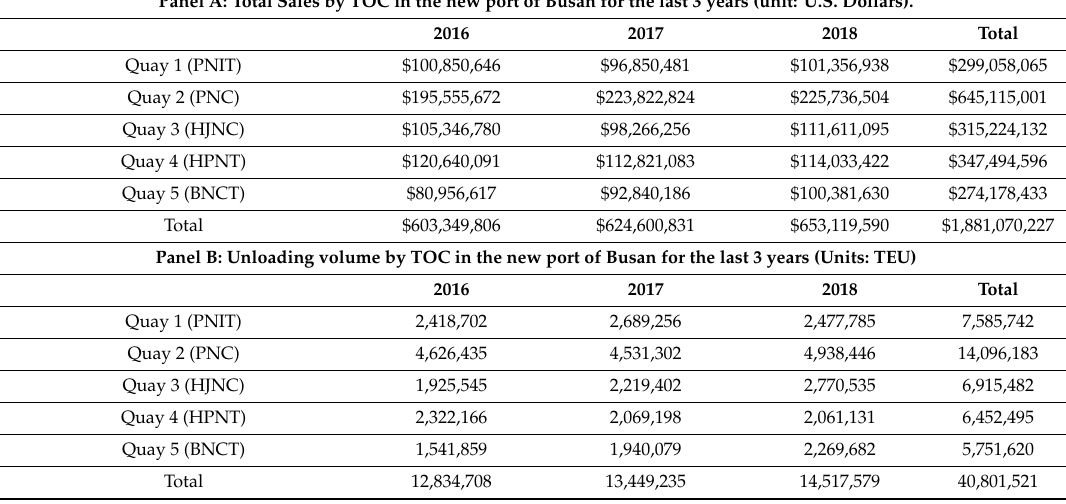
Table 10. Total sales, unloading volume, and average unloading unit price of